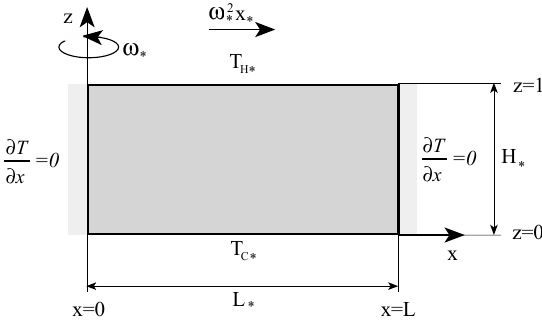
from below. For this case the centrifugal buoyancy term in Equation (33) becomes Ra